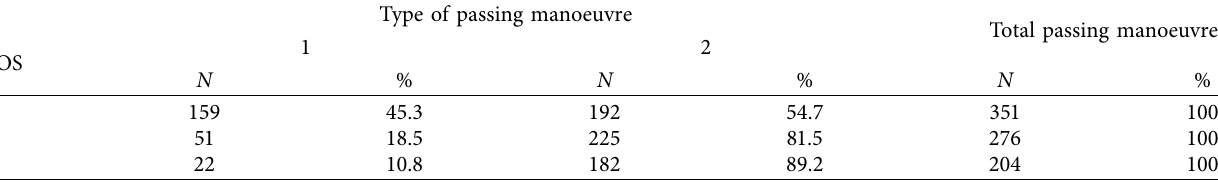
Boldface indicates statistically significant values with a 5% level of significance. Table 10: Type of manoeuvres performed according to the different LOS analysed.